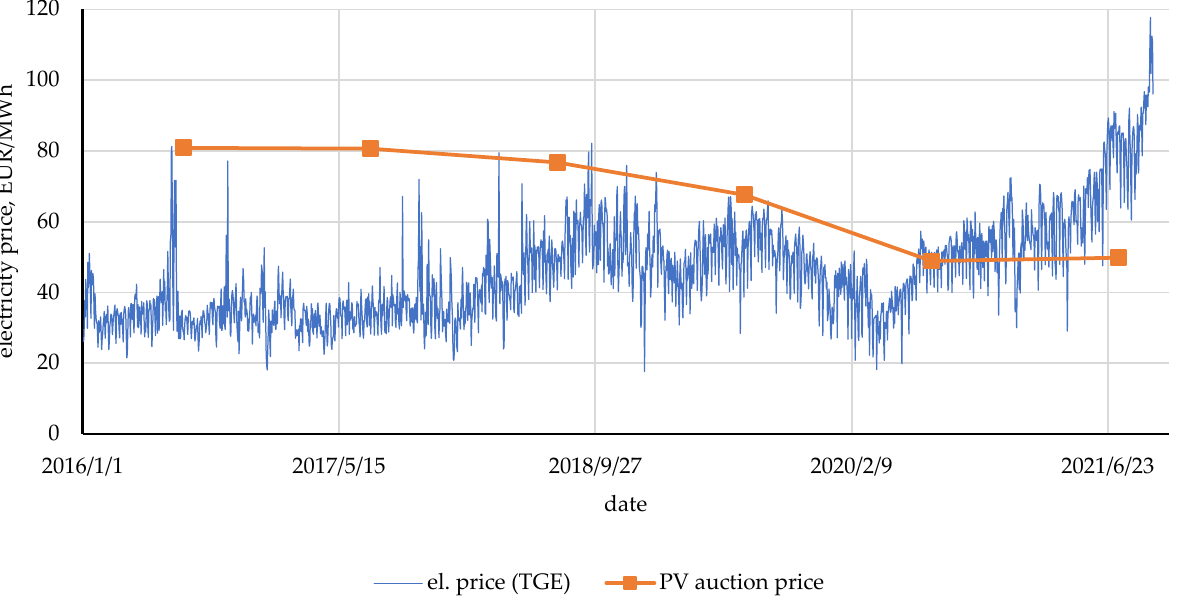
Figure 10. RES (PV) auction prices compared to the electricity price (TGE Base). Source: own study based on [38].